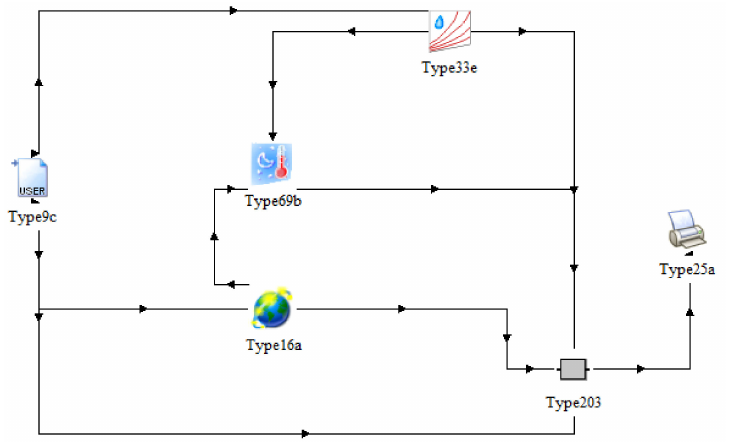
Figure 4. TRNSYS flow diagram for the PVT system with type 203 component.